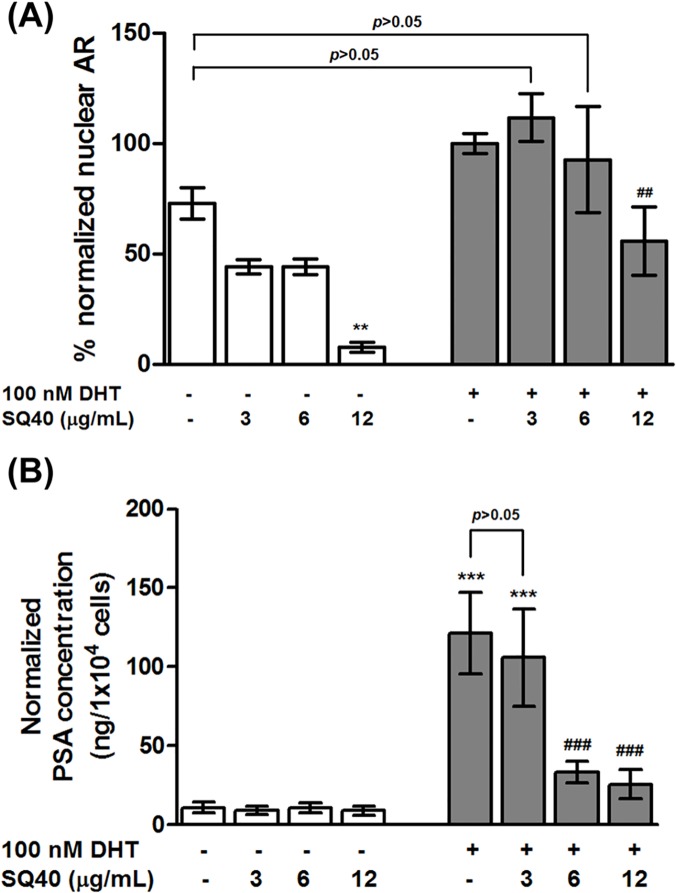
Quantitative measurement of the level of nuclear AR and PSA secretion in SQ40-treated LNCaP cells.LNCaP cells were first cultured in growth media supplemented with 5% CSS for 48 hours and then treated with 3, 6 and 12 μg/mL of SQ40 in the presence or absence of 100 nM DHT for 72 hours. Nuclear fraction of AR obtained from the cell lysate and concentrations of PSA secreted into culture medium were measured using commercial available ELISA kit. (A) AR level was normalized to the total nuclear protein level while (B) the concentration of PSA were normalised to the total cell number. Data were expressed as means ± SEM of three independent experiments and indicated as percentage of 100 nM DHT-stimulated cells set at 100%. ** indicates p<0.01; ***, p<0.001 versus unstimulated control. ###, p<0.001 versus 100 nM DHT-stimulated cells.